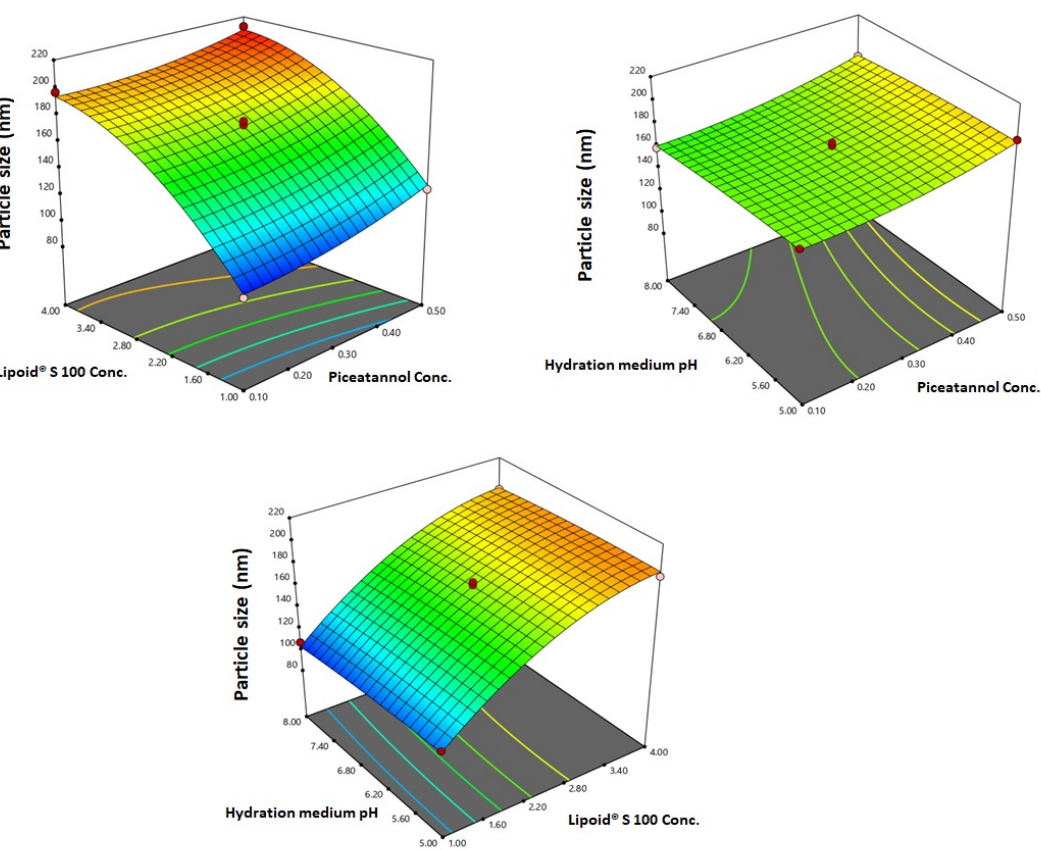
Figure 2. 3D response surface plots for the e ff ect of PIC concentration, Lipoid ® S 100 concentration, and the pH of the hydration medium on the particle size of PIC-E.